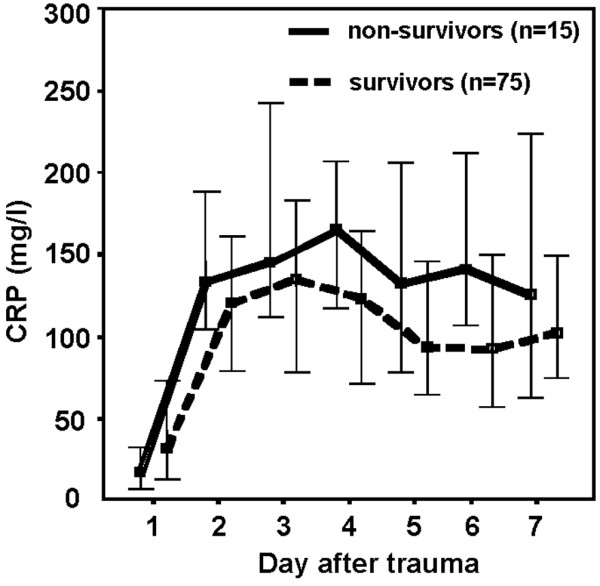
Course of C-reactive protein (CRP) (median, quartiles) during the first week after trauma in nonsurvivors (n = 15) and in survivors (n = 75).